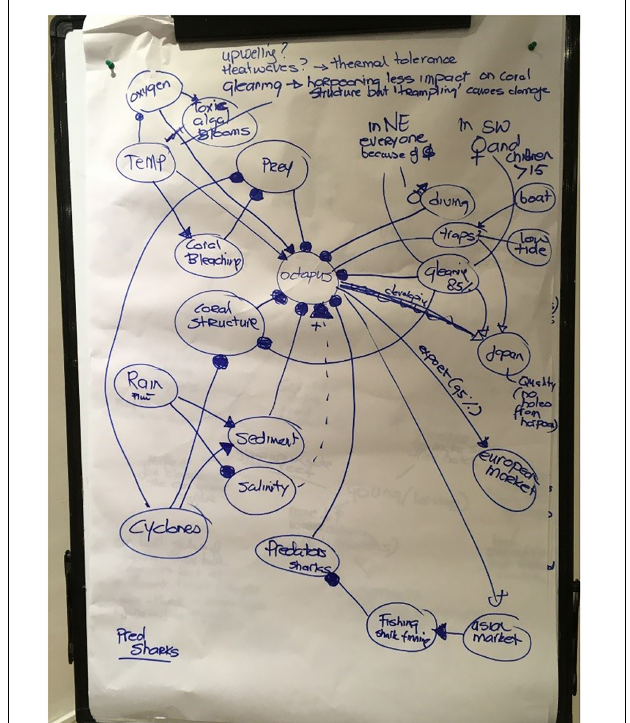
FIGURE 7 | Conceptual model for octopus developed collaboratively with workshop participants and illustrating linkages between climate and biological variables, as well as economic and social considerations, hence necessitating an integrated interdisciplinary approach for assessing vulnerability and planning adaptation